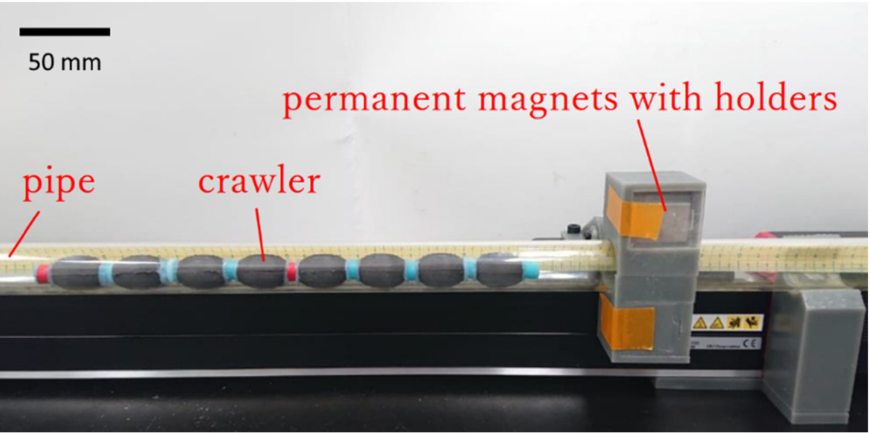
Figure 6. Experimental